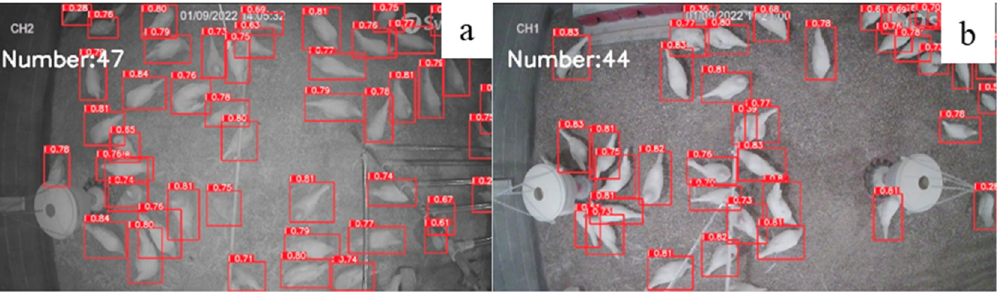
Figure 6. Number of chickens identified under different level of light intensity by our model: 10 lux ( a ) vs. 30 lux ( b ). 10 lux ( a ) vs. 30 lux ( b